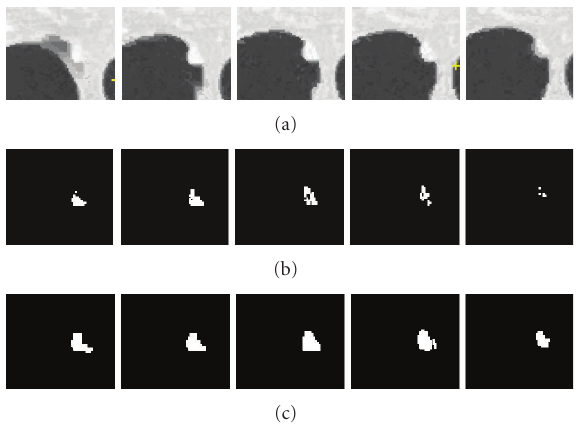
Figure 14: Another example of polyp segmentation. (a) 3D polyp in five contiguous slices; (b) segmentation results without shape feature; (c) segmentation results using the proposed